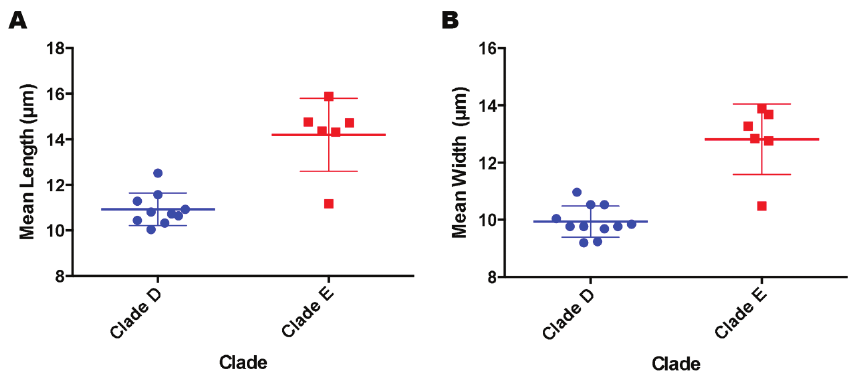
Figure 3. Mean ± SE spore ( A ) length and ( B ) width of MEXU Podaxis specimens from clades D and E. Results of Mann-Whitney U test: D–E, p <